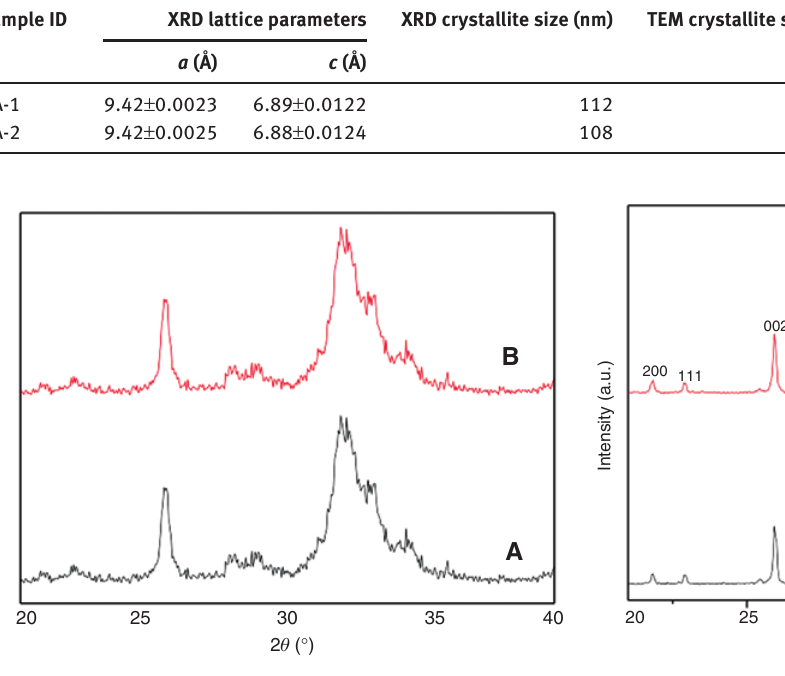
Figure 3: X-ray powder diffraction patterns of phase-pure, as- Figure 4: Powder X-ray diffraction patterns of heat-treated, phase- pure hydroxyapatite nanorods, synthesized using method 1 (A) and method 2 (B) via co-precipitation